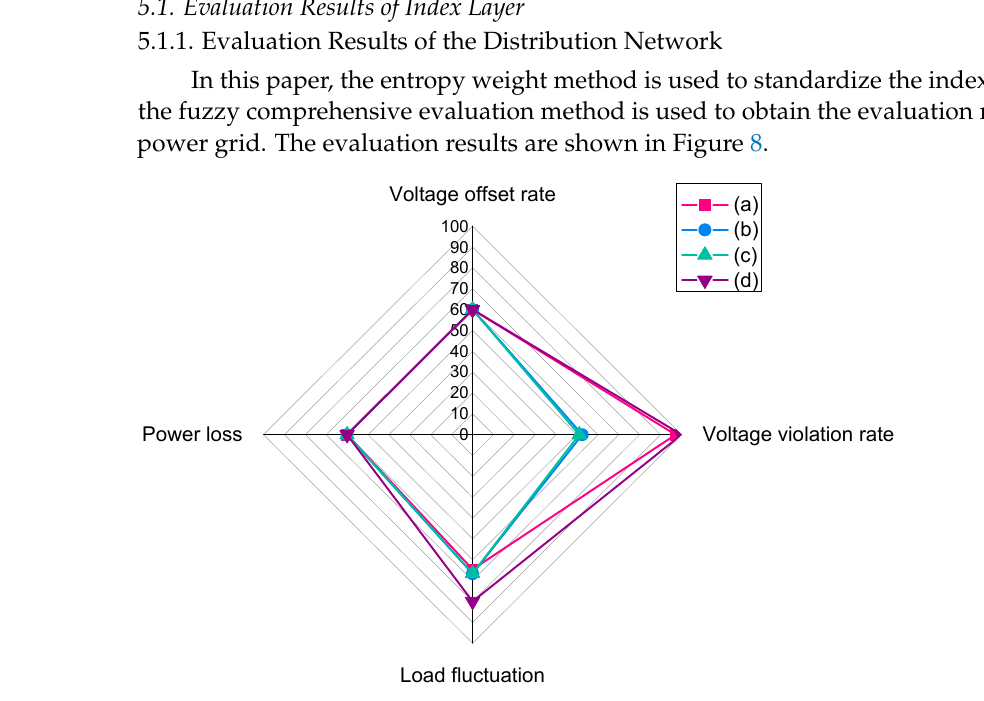
Figure 8. Evaluation results of distribution network.